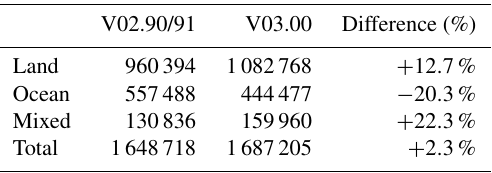
Table 5. Number of observations from the V02.90/91 and V03.00 XCO 2 products and their differences for each surface type from the launch to